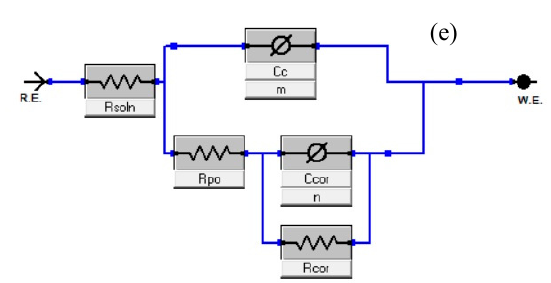
Figure 8. Bode graph of TNTs loaded with DOC ( a ), 5 wt.% at pH 2 ( b ), 5 wt.% at pH 5, phase angle measured of TNTs loaded with DOC ( c ), 5 wt.% at pH 2 ( d ), 5 wt.% at pH 5 ( e ); equivalent circuit used for fitting of EIS data. Table 1. Electrochemical impedance parameters from measured impedance data for coating of 5 wt.% TNTs loaded with DOC at pH 2 and 5.